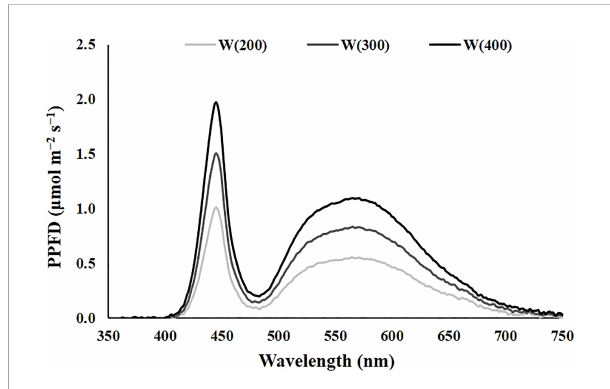
FIGURE 1 The spectrum of the light treatments applied in experiment 1. Cool